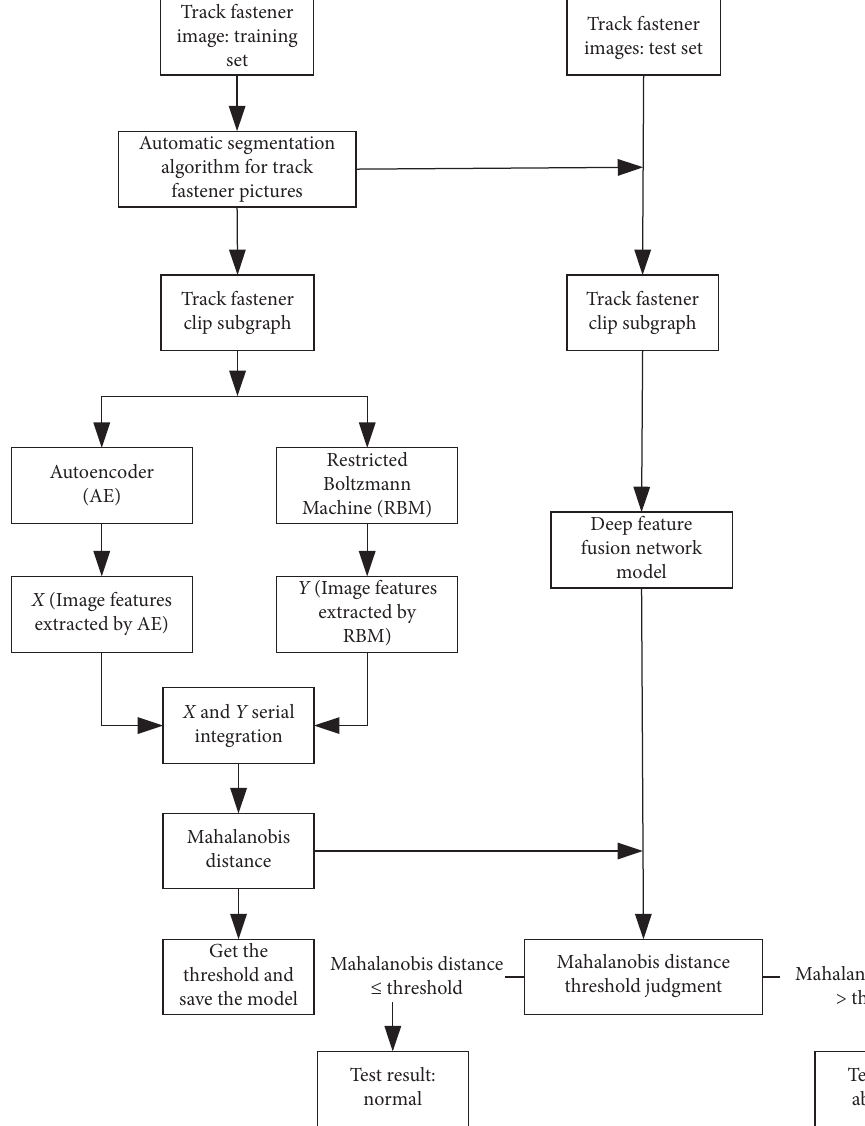
Figure 3: Flow chart of detection of defects in Pandrol track fasteners based on